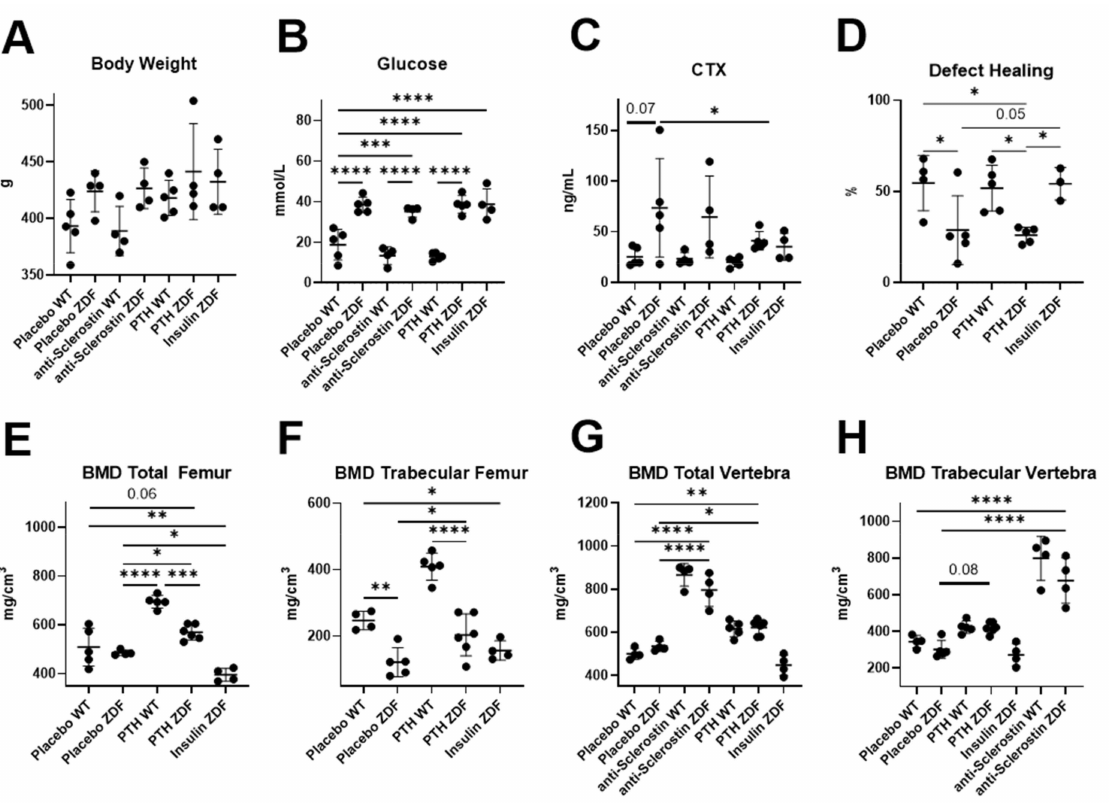
Figure 1. Re-analyzed characterization of animal phenotypes. Metabolic parameters ( A – C ), as well as femoral ( D – F ) and vertebral bone parameters ( G , H ), were evaluated. Ex vivo micro-CT analyses were performed to determine BV/TV and BMD (placebo WT, n = 5; placebo ZDF, n = 5, PTH ZDF, n = 5; insulin ZDF, n = 4; anti-scl ZDF, n = 4). Scatterplots show mean ± SD. Two-way ANOVA analysis was performed. p < 0.1 shown in numeric values, * p < 0.05, ** p < 0.01, *** p < 0.001, **** p <